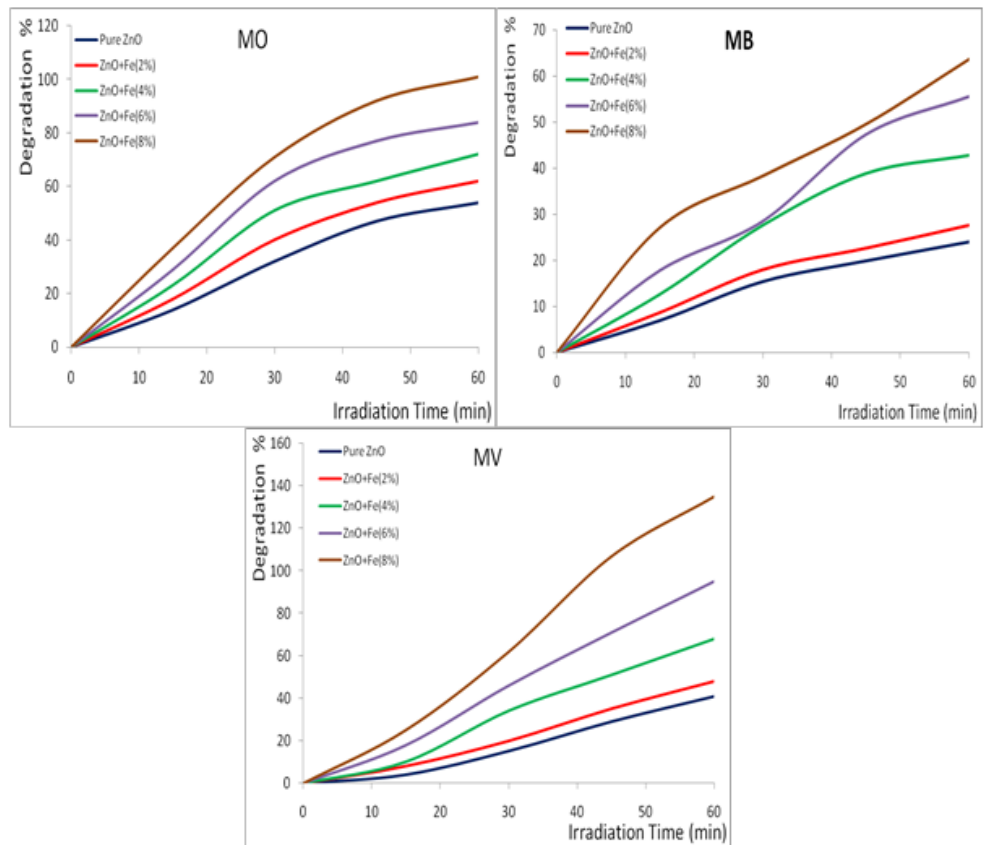
Fig.11: Degradation of aqueous MO, MB and MV solution as a function of irradiation light time of the ZnO thin films immersed in